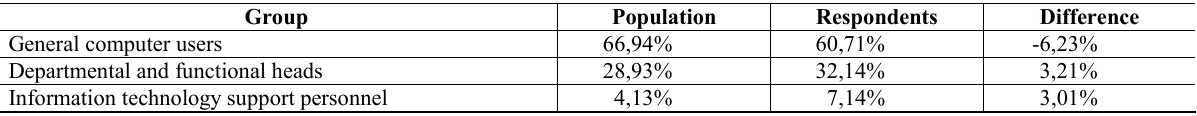
Table 2: Differences between the composition of the population and respondents Group Population